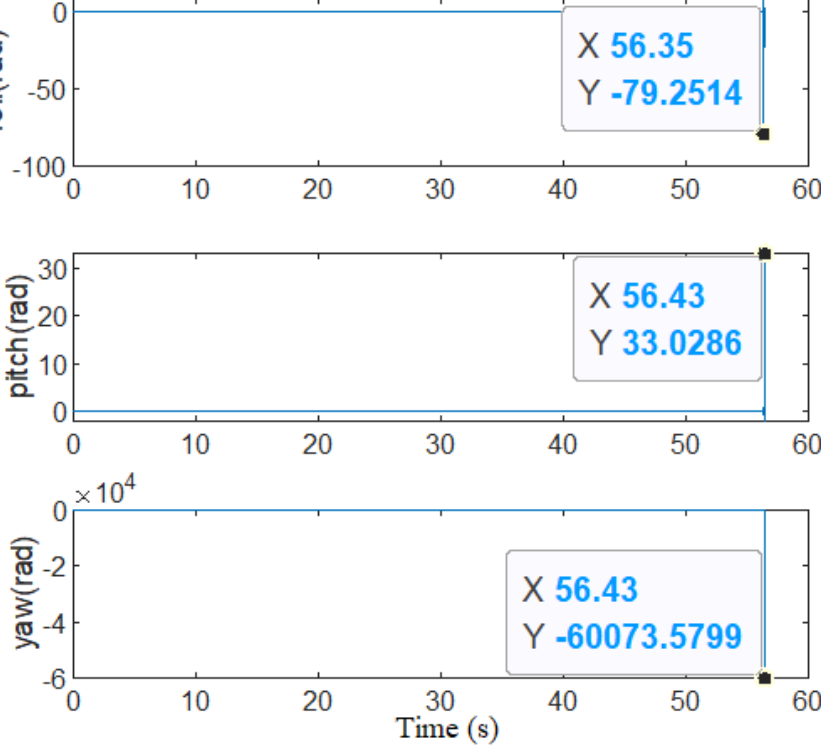
Figure 25. Multiplication fault: control result of Euler angle without sensor